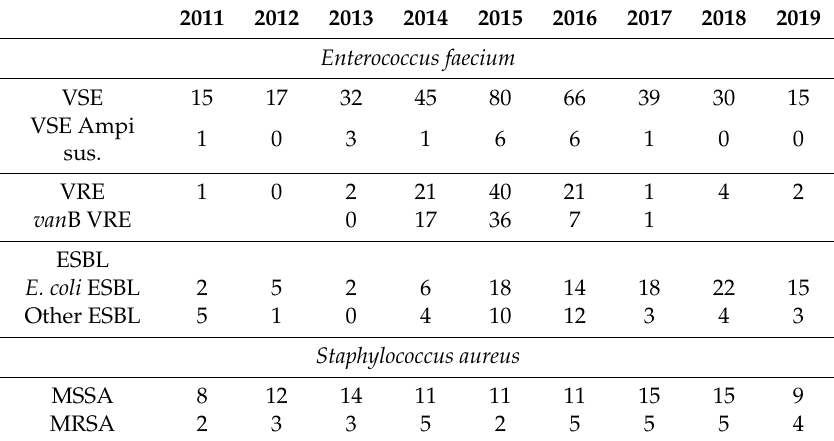
Table 1. Number of patients per year on ERWIN colonized with vancomycin-susceptible Enterococcus faecium (VSE), vancomycin resistant E. faecium (VRE), Gram-negative bacteria producing extended spectrum beta-lactamase (ESBL), methicillin resistant S. aureus (MRSA), and methicillin-susceptible S. aureus (MSSA). Systematic analysis of genotype mediating vancomycin resistance of VRE was performed from 2013–2016. Ampi sus.: Ampicillin-susceptible.